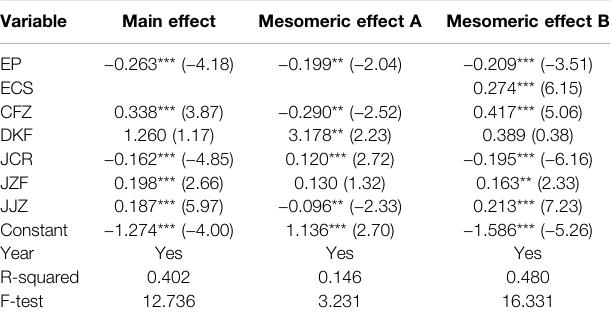
TABLE 8 | Robustness test